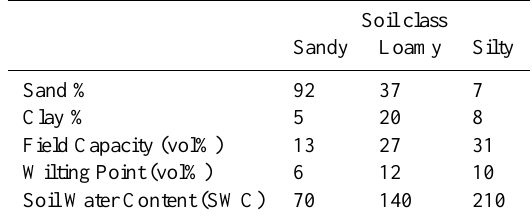
Table 2. Characteristics of soils used to train the ANN. Soil Wa- ter Content (mm) calculated as difference between water content at field capacity and at wilting point for 1m